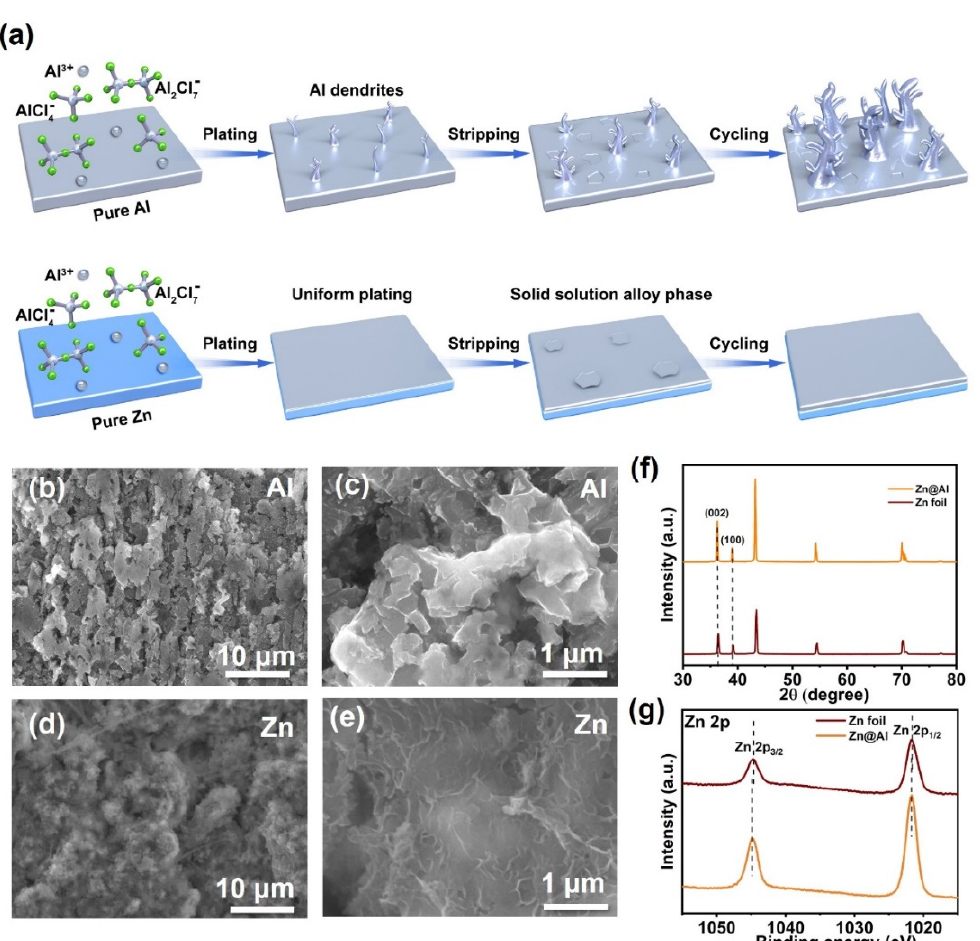
Figure 4. ( a ) Schematic illustration of Al plating/stripping in Al substrate and Zn substrate. ( b , c ) SEM images of Al plating on Al foil with a capacity of 20 A·g − 1 in the Al–graphite cells. ( d , e ) SEM images of Al plating on Zn foil with a capacity of 20 A·g − 1 in the Zn@Al–graphite cells. ( f ) XRD patterns of Zn foil and Zn@Al. ( g ) Zn 2p XPS spectra of Zn foil and